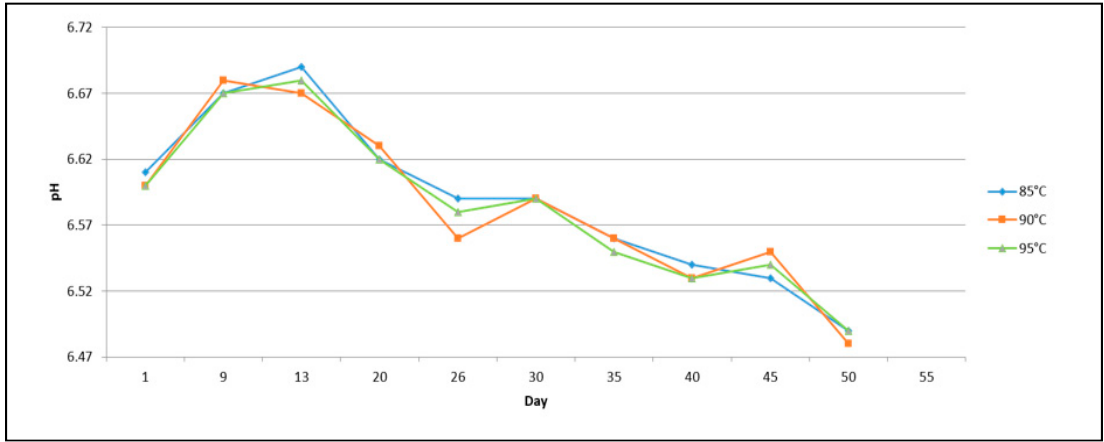
Figure 6. Measurements of pH during a storage period of 55 days at 4 °C.